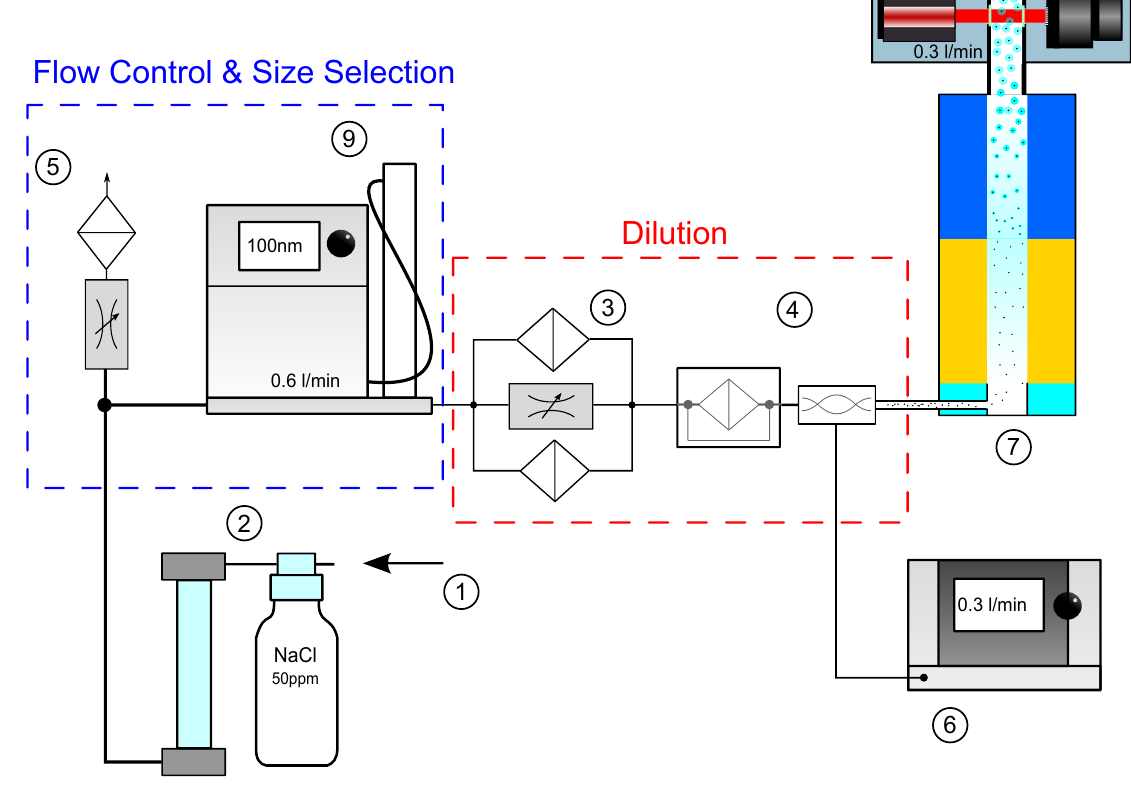
Figure 5. Experimental Setup for measurement of particle